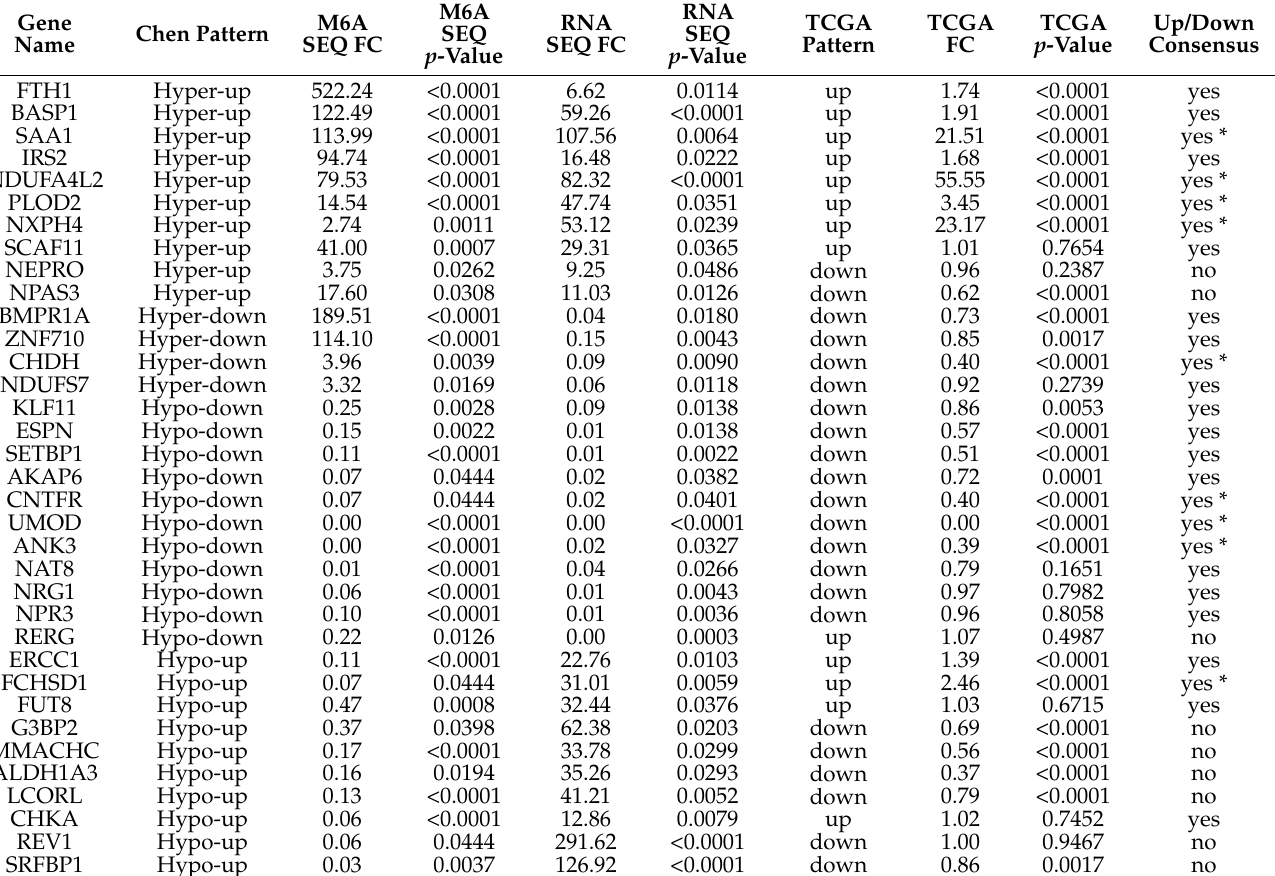
Table 1. TCGA expression validation analysis data. Detailed expression information for the 35 m6A- driven defined target genes identified by Chen et al. (21). m6A-seq fold changes (fc), p -values, and RNA-seq fc and p -values were obtained from the original publication. * The “Consensus up/down” column indicates an mRNA dysregulation pattern that is consistent across the Chen and TCGA-KIRC cohorts and meets the significance criteria ( p -value < 0.05 and fc > 2 or <0.5).